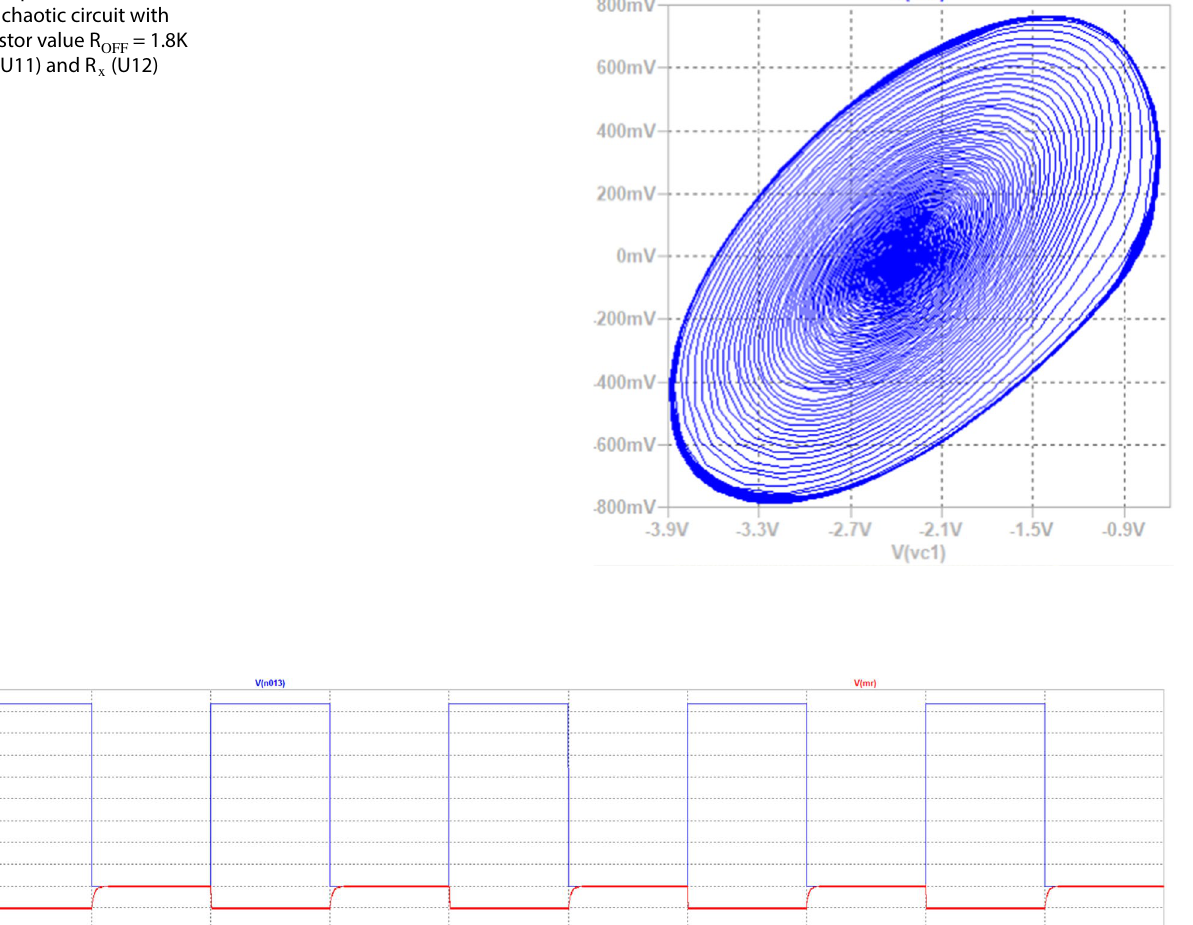
Fig. 16 Spiral attractor of Chua’s chaotic circuit with